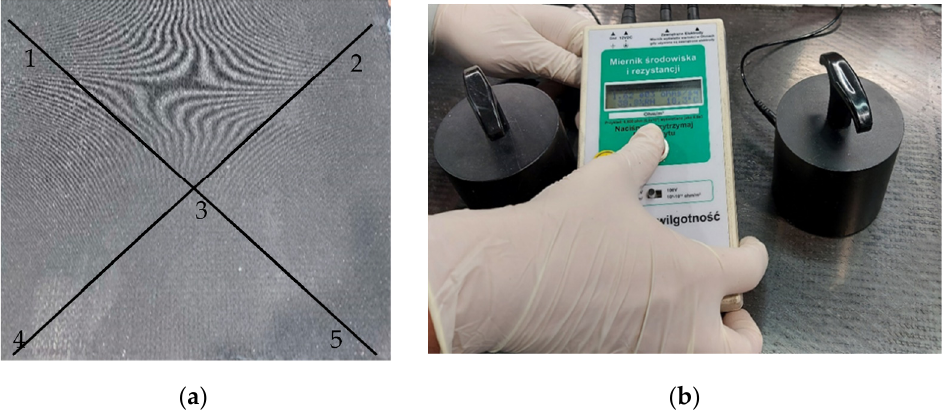
Figure 3. View of the samples with measurement points ( a ). Device for measuring surface resistivity ( b ).